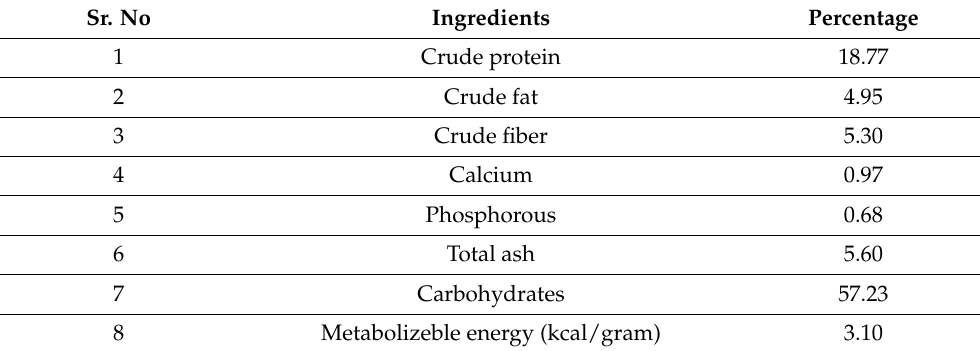
Table 2. Nutritional composition of normal pelleted diet for rats